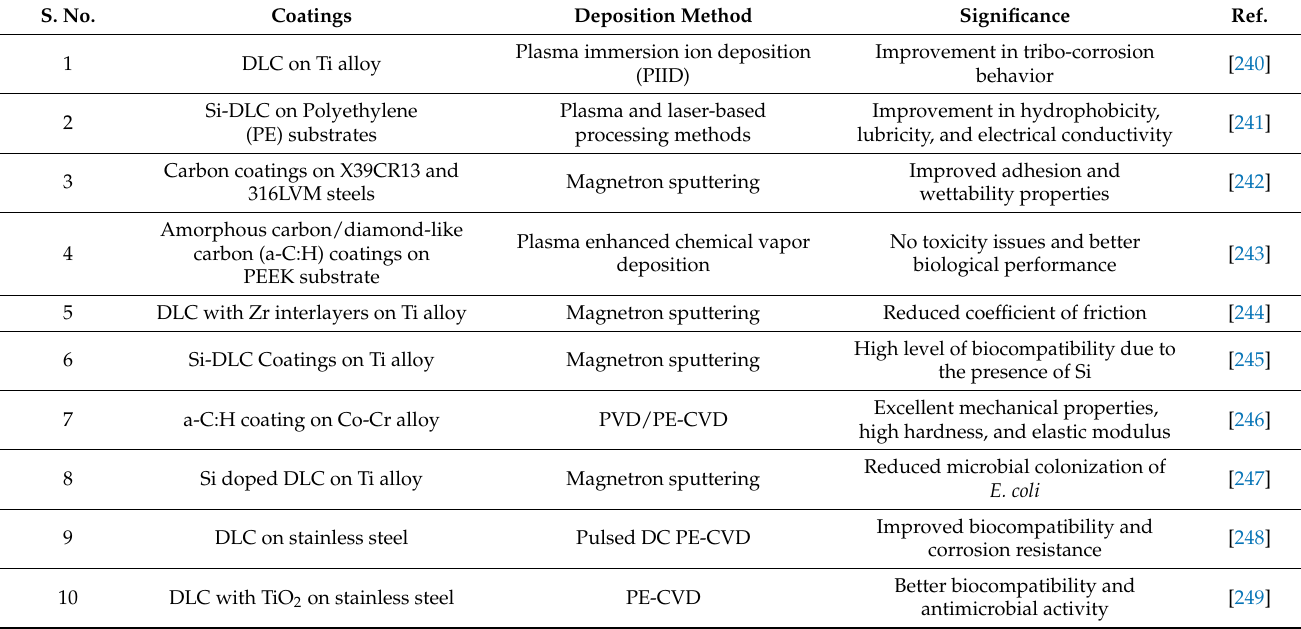
Table 6. Different carbon coatings and their